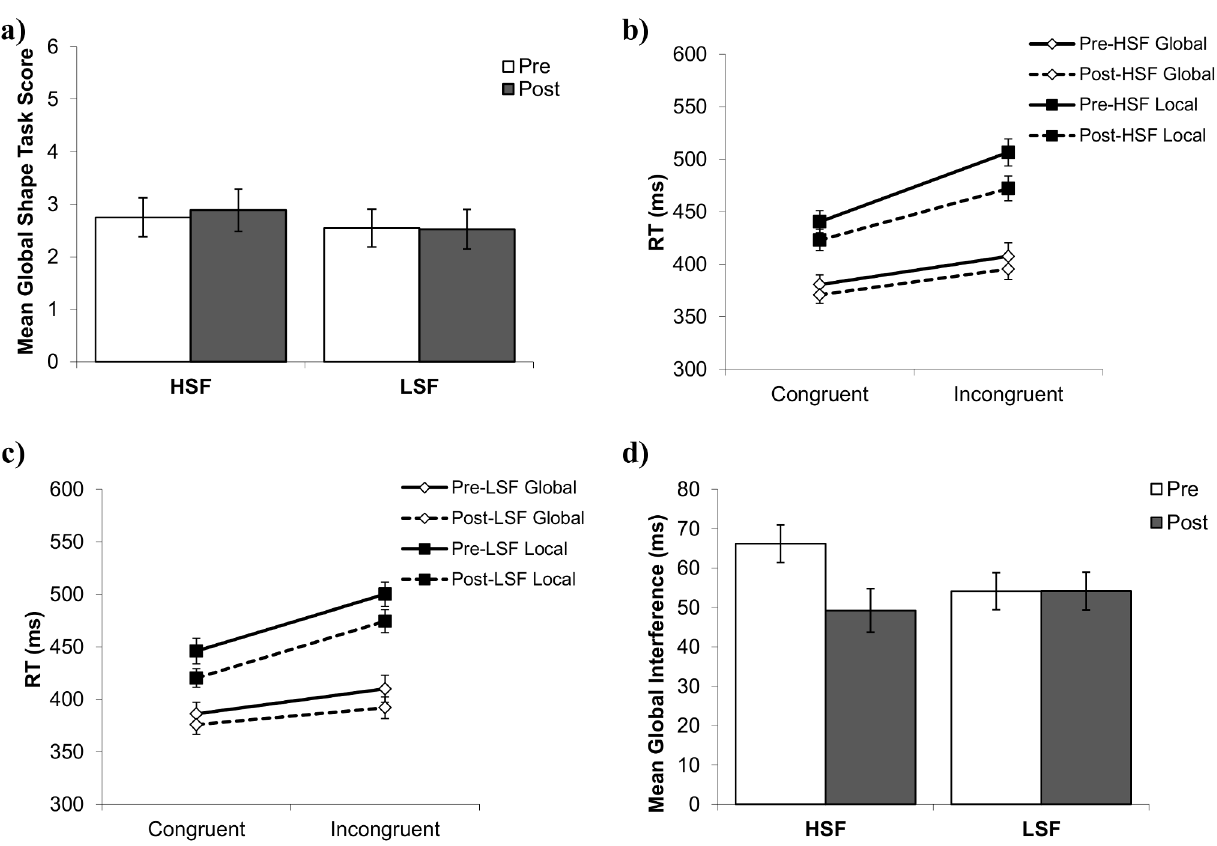
Figure 5. Experiment 2a and b pattern of means. (a) Experiment 2a mean pre- and post-manipulation global shape task scores as a function of viewing LSF or HSF gratings in the manipulation task. (b) Experiment 2b mean RTs on the Navon task, as a function of pre- and post-manipulation, stimulus level (global or local), and target congruency in the HSF condition and (c) in the LSF manipulation condition. (d) Experiment 2b mean pre- and post-manipulation global Navon interference scores as a function of viewing LSF or HSF gratings in the manipulation